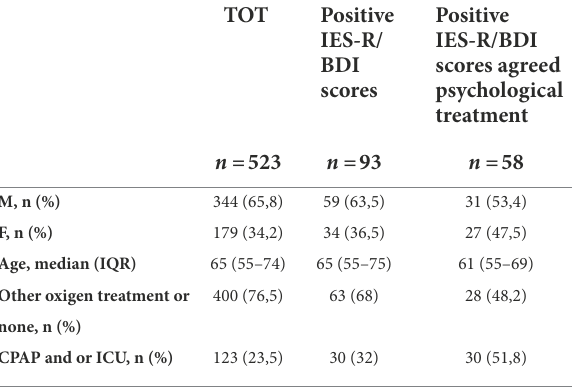
TABLE 1 Demographic and oxigen therapy information of patients referred for follow up visit after hospitalization for